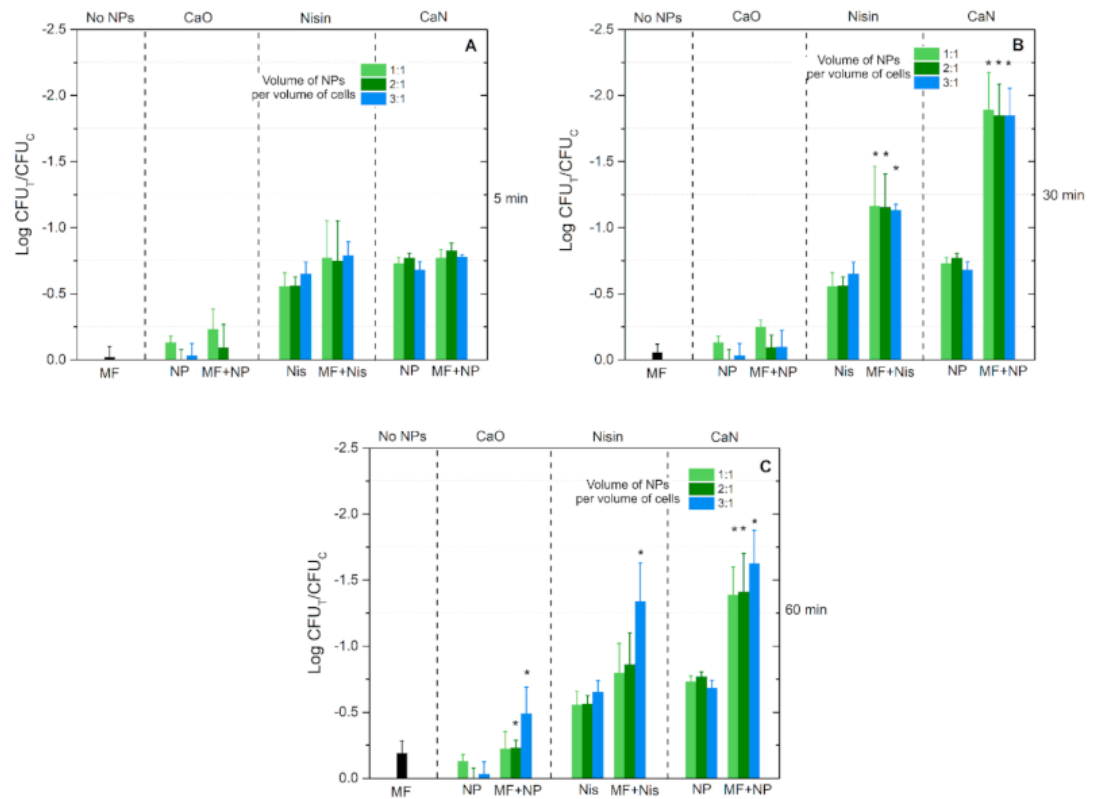
Figure 7. The viability response of L. innocua to low alternating magnetic field (10 mT, 100 kHz) and activated nisin-loaded (CaN), nisin-free (CaO) magnetic nanoparticles or nisin-only solution (Nisin). ( A ) After 5 min exposure; ( B ) 30 min exposure and ( C ) 60 min exposure. In all cases the treatment (CFU T ) is normalized to untreated control samples (CFU C ). Asterisk (*) corresponds to statistically significant difference ( p < 0.05) versus NP-only or nisin-only